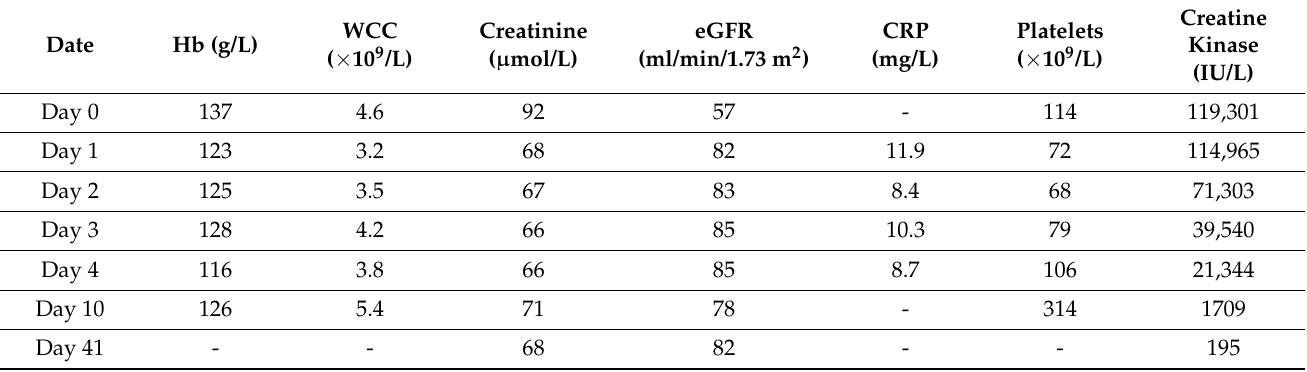
Table 1. Blood test results during admission and at follow up. Day 0 indicates day of presentation and admission to